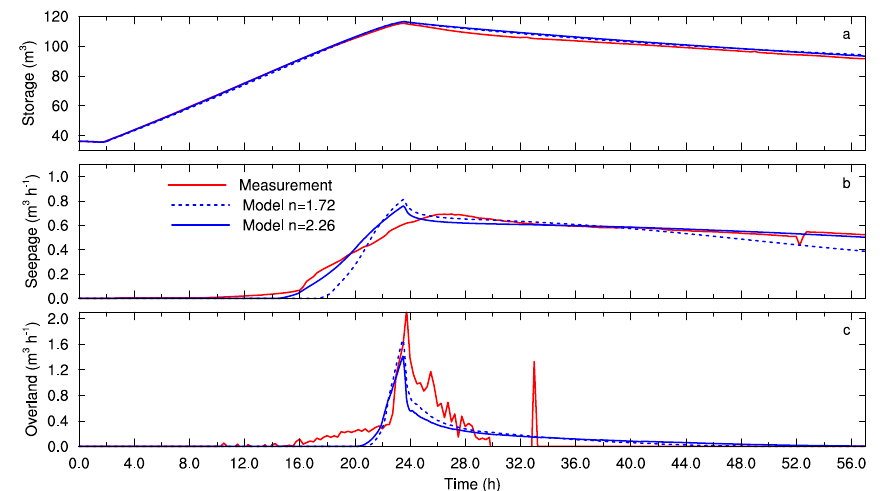
Figure 9. Comparison between the measured total water storage (a) , seepage face flow (b) , and overland flow (c) and the simulated results obtained with the optimized parameter values for M3_Hetero ( n =1.72) and M4_Hetero ( n